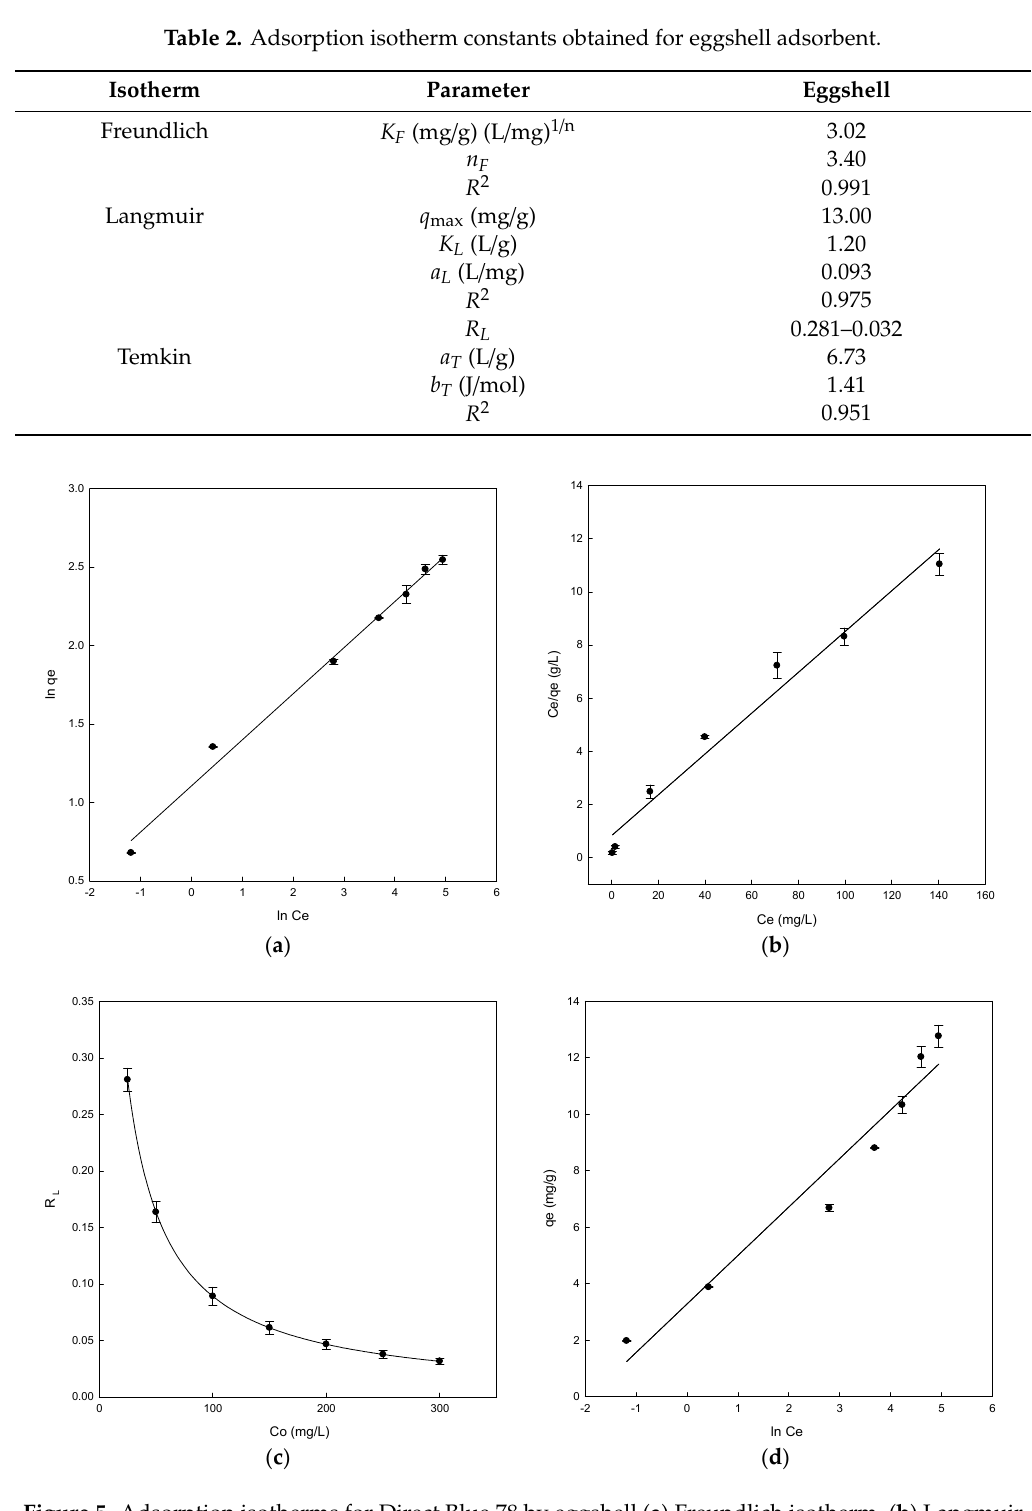
Figure 5. Adsorption isotherms for Direct Blue 78 by eggshell ( a ) Freundlich isotherm, ( b ) Langmuir isotherm, ( c ) separation factor, and ( d ) Temkin isotherm. Table 2. Adsorption isotherm constants obtained for eggshell adsorbent.